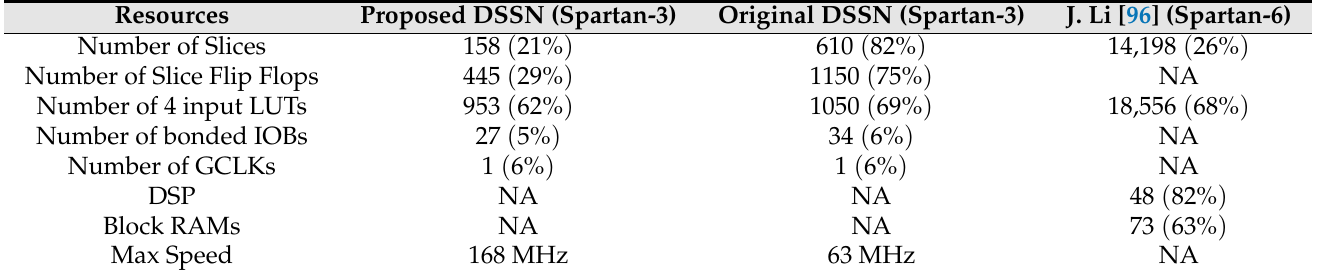
Table 6. FPGA Utilization Results for the Different DSSN Models.